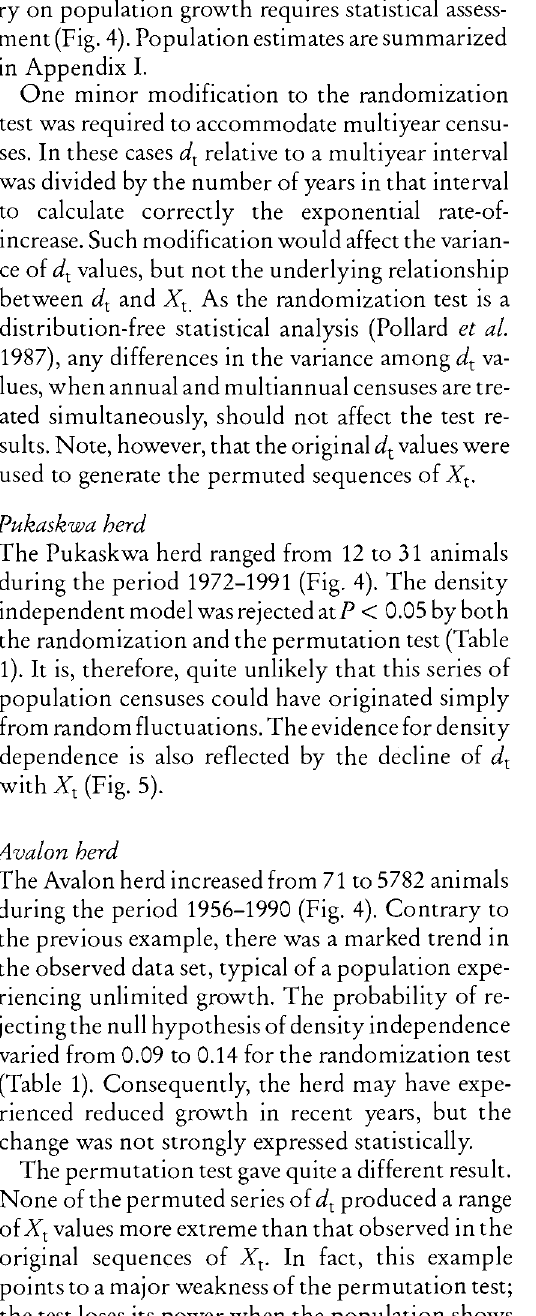
Figure 4. Fluctuations over time of caribou numbers for the Pukaskwa herd in Ontario, the Avalon herd in Newfoundland, and the computer- constructed